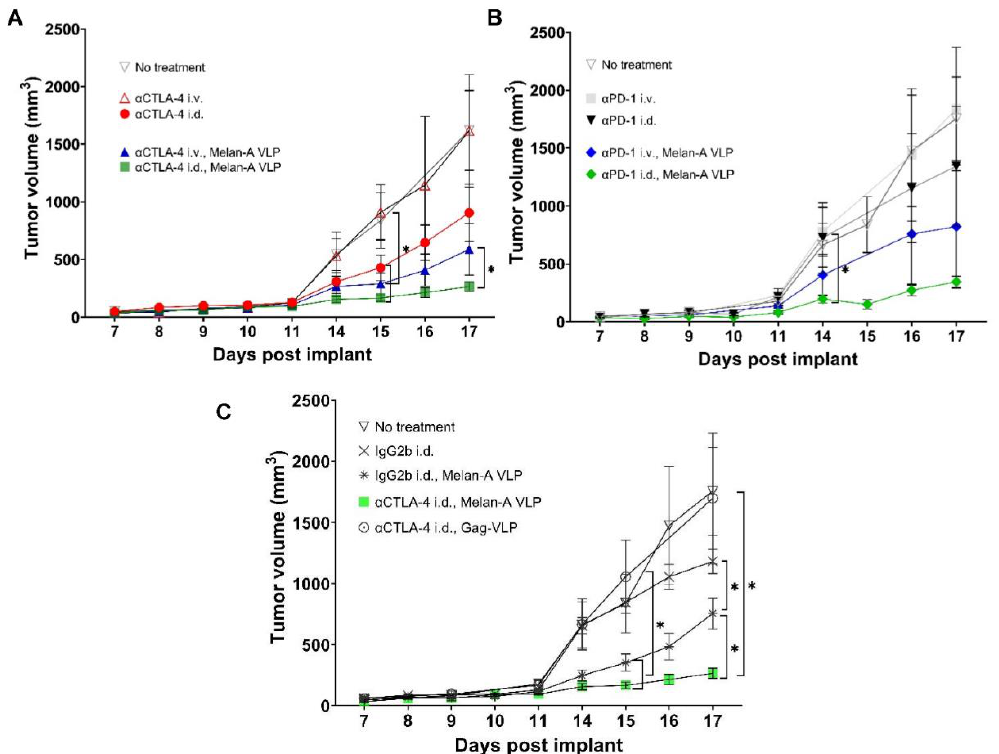
Figure 4. ( A ) Lymphatic delivery of α CTLA-4 monotherapy alone or in combination with Melan-A VLP significantly reduces tumor growth. Primary tumor volume versus d.p.i. for untreated animals ( ▽ , grey n = 5); and animals dosed with α CTLA-4 i.v. ( △ , red, n = 5); α CTLA-4 i.d. ( ● , red, n = 7); α CTLA-4 i.v., Melan-A VLP ( ▲ , blue, n = 10); and α CTLA-4 i.d., Melan-A VLP ( ■ , green n = 10). ( B ) Lymphatic delivery of α PD-1 monotherapy alone or in combination with Melan-A VLP significantly reduces tumor growth. Primary tumor volume versus d.p.i. for untreated animals ( ▽ , grey n = 5); and animals dosed with α PD-1 i.v. ( ■ , grey n = 4); α PD-1 i.d. ( ▼ , black, n = 9); α PD-1 i.v., Melan-A VLP ( ♦ , blue, n = 4); and α PD-1 i.d., Melan-A VLP ( ♦ green, n = 10). ( C ) Lymphatic delivery of Melan-A VLP alone significantly reduces tumor growth. Primary tumor volume versus days post implant for untreated animals ( ▽ , grey n = 5); and animals dosed with IgG2b i.d. (X, grey n = 4); IgG2b i.d., Melan-A VLP ( ✱ , grey, n = 4); α CTLA-4 i.d., Melan-A VLP ( ■ , green n = 10); and α CTLA-4 i.d., Gag-VLP ( ○ , grey n = 10). * Denotes first time point of statistical significance from unpaired, two-tailed Student’s t test ( p < 0.05). Error bars indicate SEM. i.v., intravenous; i.d., intradermal.